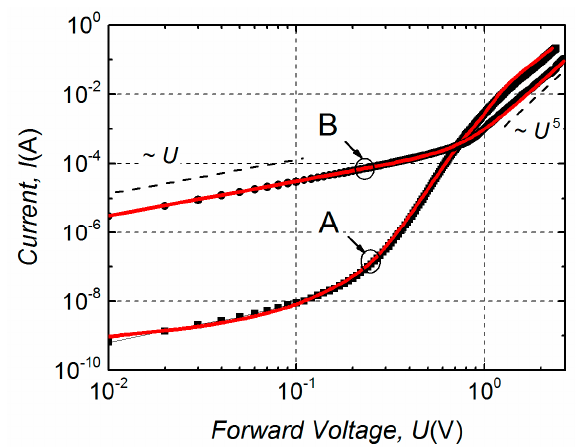
Figure 7. Typical I – U characteristics of the group A and B LDs in the current range far below the threshold; the black symbols represent experimental results and the red solid curves—an approximation by Equation (3) for the group A and by Equation (2) for the group B.